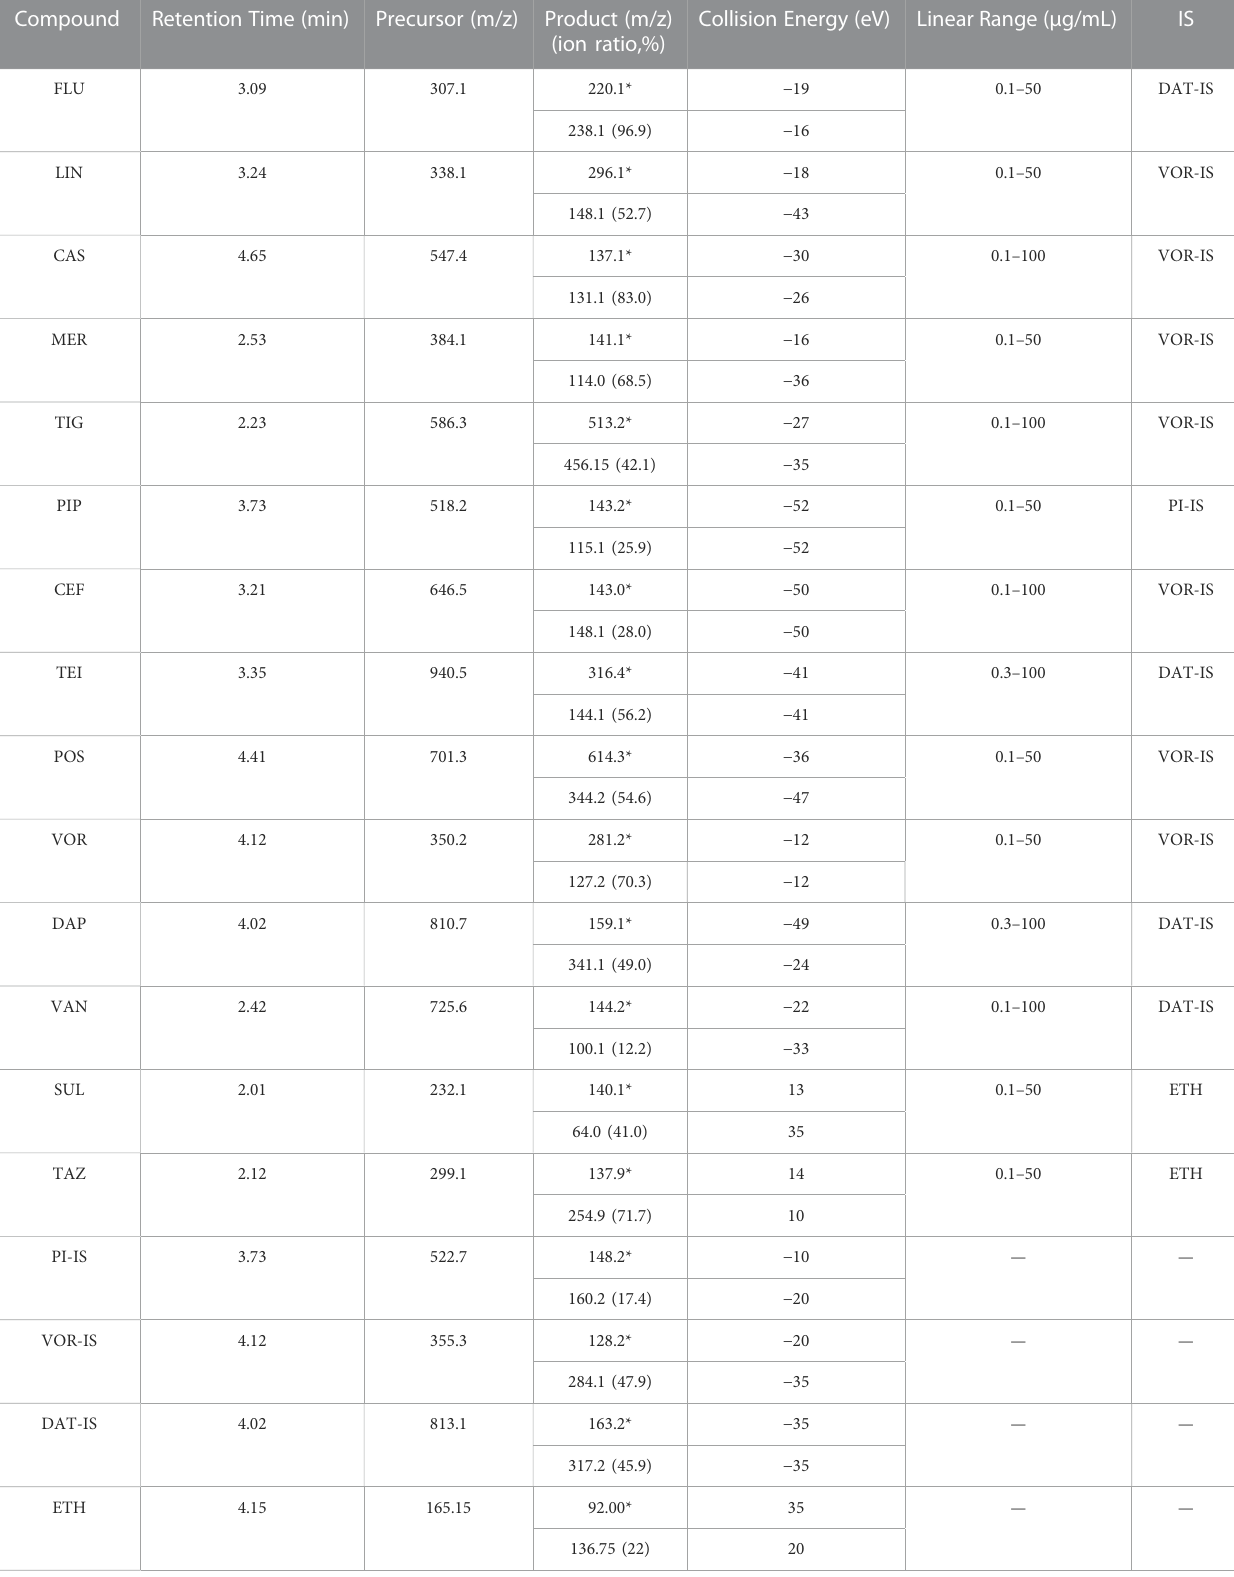
TABLE 1 Retention times, ionization conditions, linear ranges, and corresponding ISs for 14 antibacterial